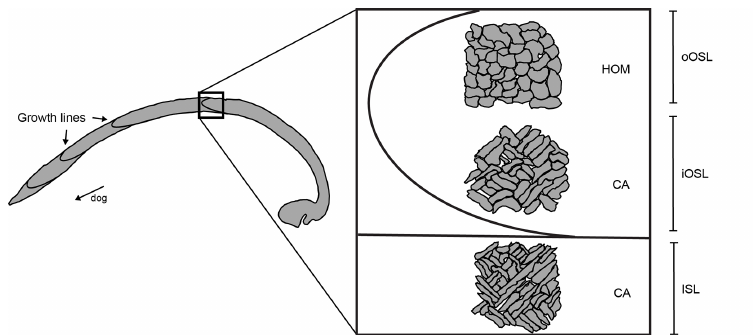
Figure 2. Sketch showing the microstructures characterizing the different shell layers of Arctica islandica . The oOSL is formed by homoge- nous microstructure (HOM), whereas the oOSL and ISL are composed of crossed acicular structure (CA); dog is direction of